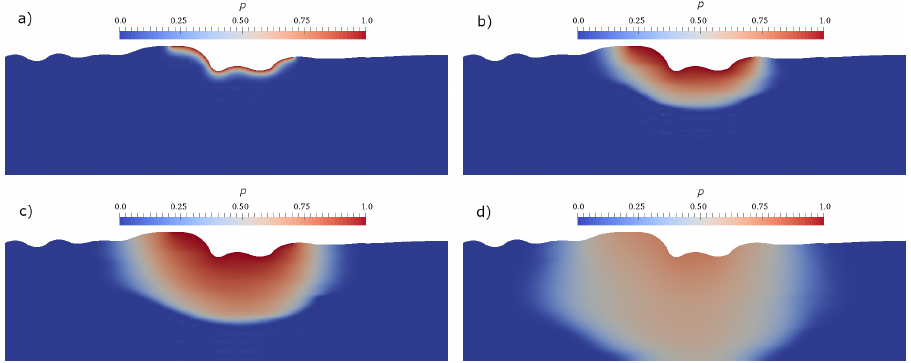
Figure 4. Numerical results for pressure that correspond to time step: ( a ) τ = 128 ( b ) τ = 150 ( c ) τ = 200 ( d ) τ = 365. This results are coarse grid solutions using 8 basis functions ( DOF c =